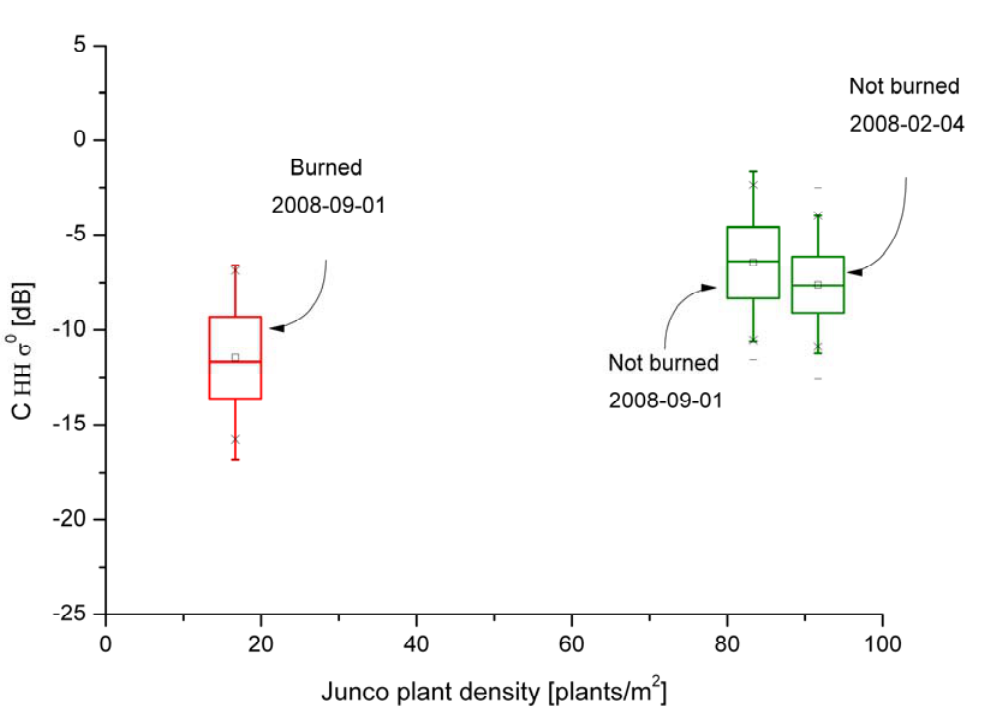
Figure 4. Box plots of C HH σ 0 values of junco marsh sites in normal condition (green), and for the burned condition (red). The associated mean junco plant density (JPD, plants/m 2 ) measured in the field sites is also